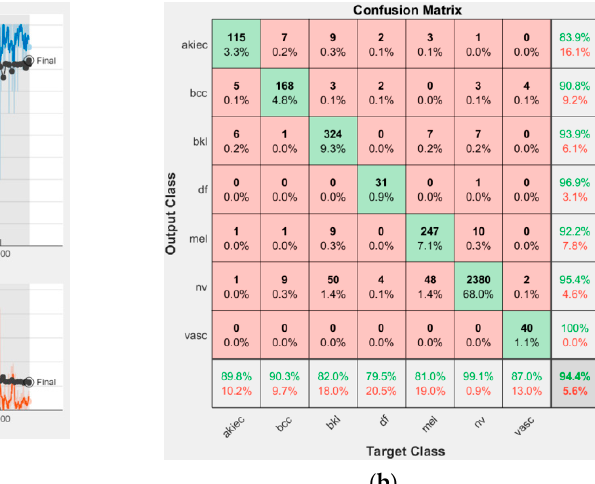
Figure 11. Results using ResNet-50, ( a ) Accuracy and loss, ( b ) Confusion matrix.